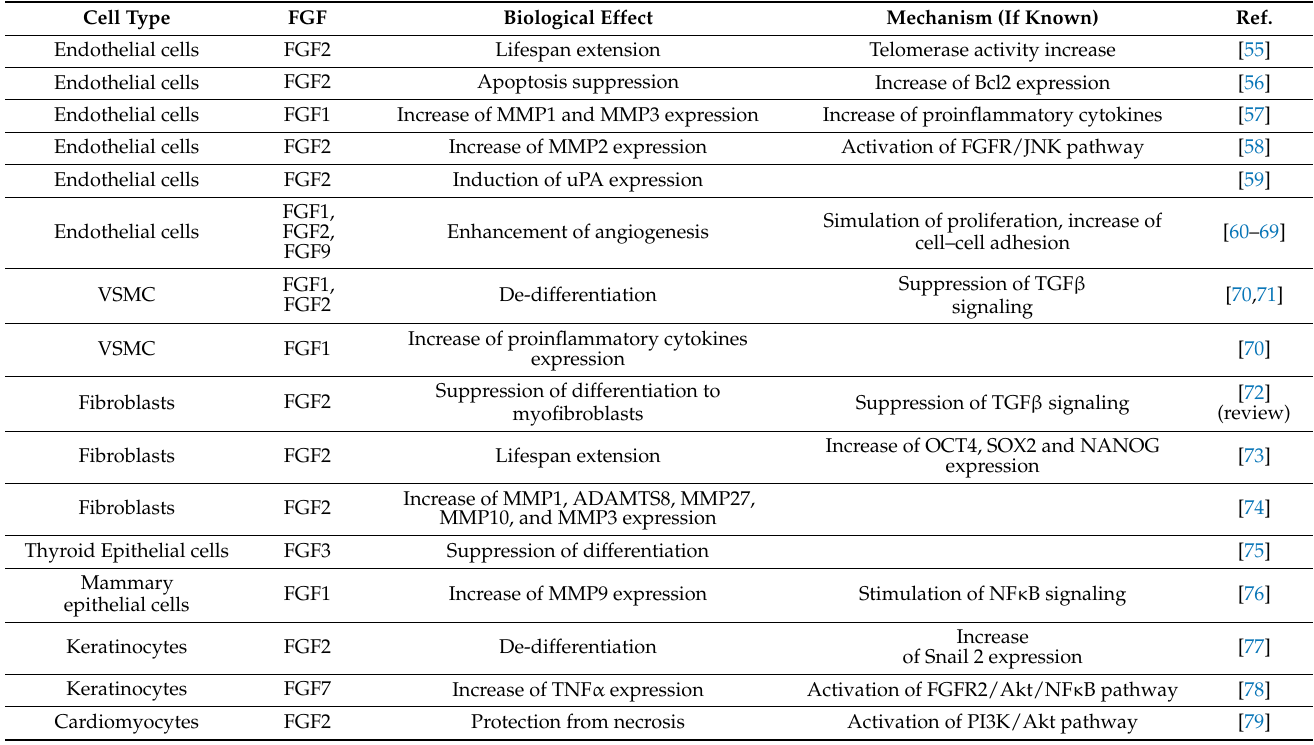
Figure 3. Cellular processes regulated by FGFs. Table 1. Biological effects of FGFs in different cell types.